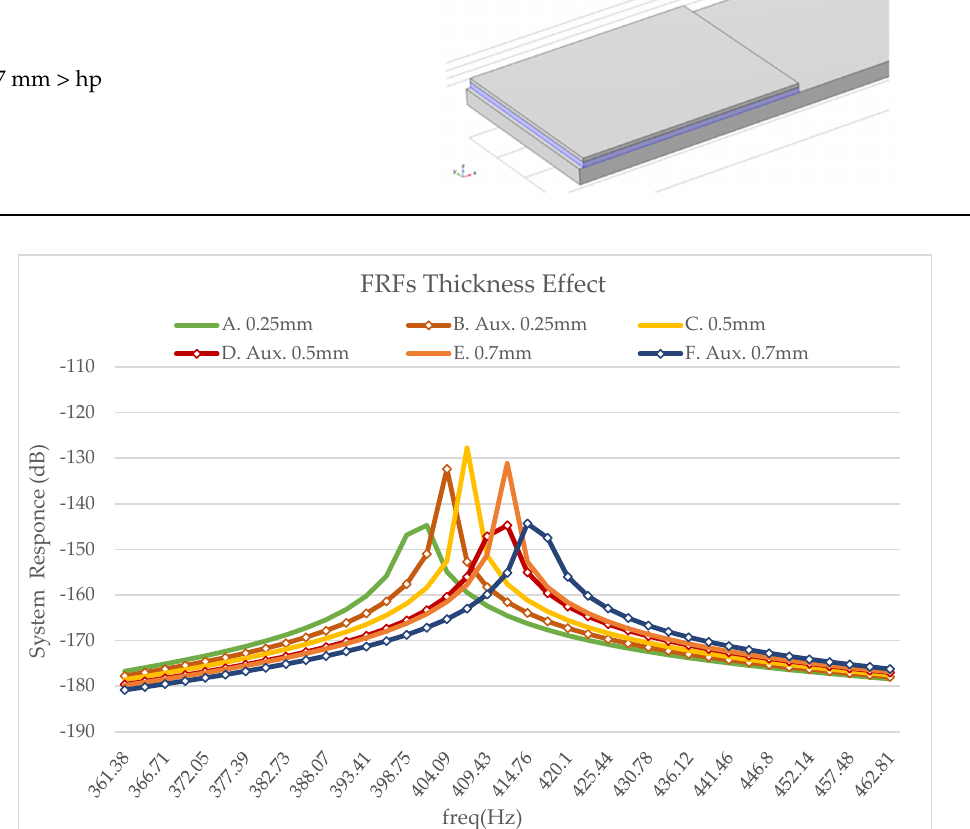
Figure 10. Simulated frequency response for the second eigenmode. Aluminum beam, Piezo. PIC151, additional layer hA and open circuit- A. vxy = 0.202 hA = 0.25 mm, B. vxy = — 0.202 hA = 0.25 mm, C. vxy = 0.202 hA = 0.5 mm, D. vxy = — 0.202 hA = 0.5 mm, E. vxy = 0.202 hA = 0.7 mm, F. vxy = — 0.202 hA = 0.7 mm.